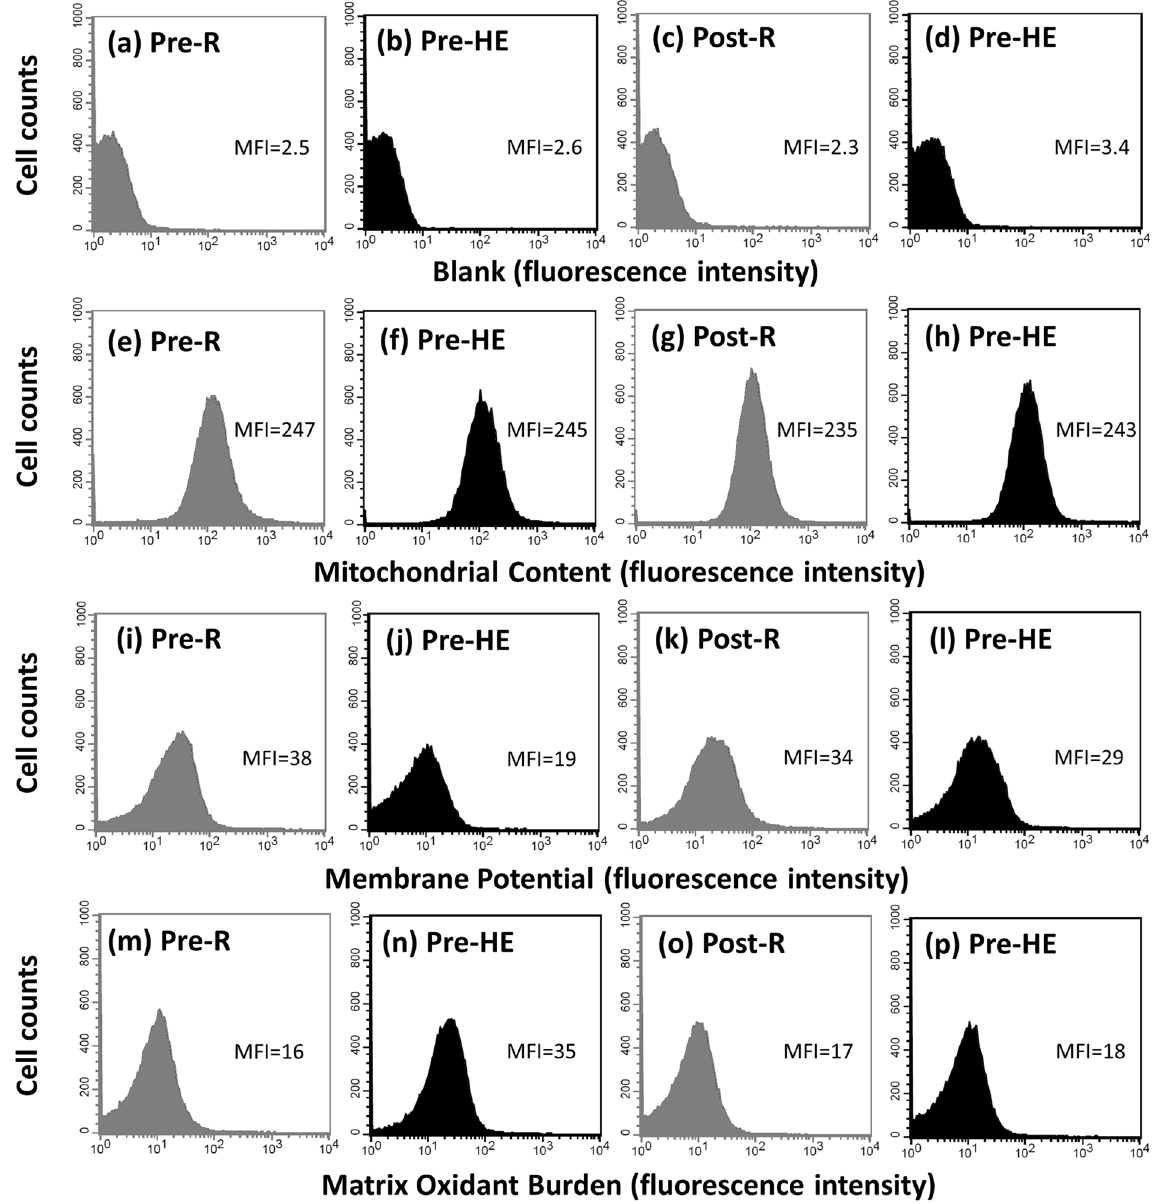
Figure 1. Graph showing the effect of high-intensity interval training ( HIT ) on mitochondrial content, mitochondrial membrane potential, and matrix oxidant burden in platelets using a FACScan flow cytometer. Pre , before HIT; Post , after HIT; R , resting; HE , hypoxic (12%O 2 ) exercise test. Blank (a–d) , platelets without treating fluorescent dye; Mitochondrial content (e–h) , platelets stained with MitoTracker Green FM; Mitochondrial membrane potential (i–l) , platelet stained with tetramethylrhodamine ethyl ester; Matrix oxidant burden (m–p) , platelet stained with MitoSOX Red; MFI , mean fluorescence